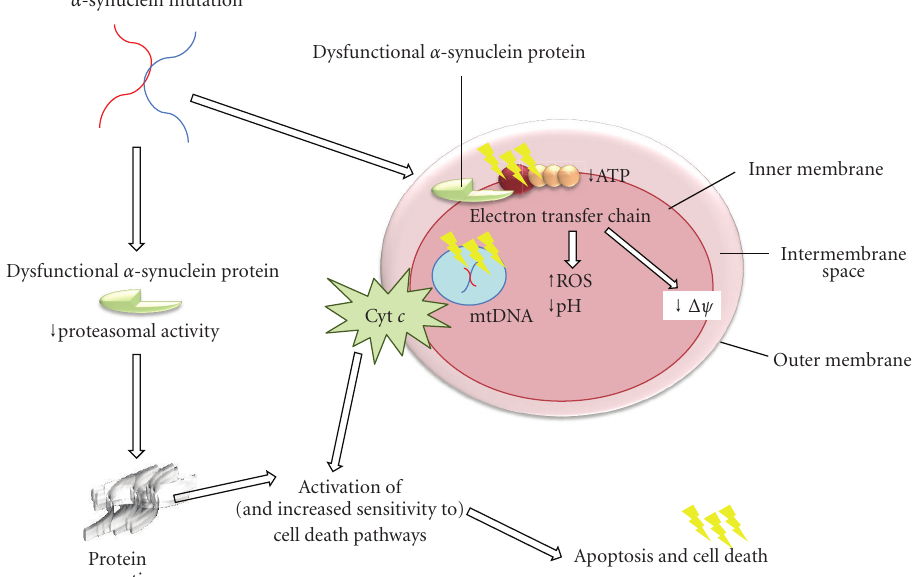
Figure 1: Genetic mutation of α -synuclein and subsequent protein and biochemical alterations . Modifications to the α -synuclein gene cause dysfunction of its protein product. Proteasomal activity becomes impaired, leading to an increased tendency for the protein to aggregate. Mutated α -synuclein protein also localises at the inner mitochondrial membrane, causing complex I dysfunction. ATP production is subsequently reduced, as is the transmembrane potential of the organelle. Increased levels of ROS result, and with mtDNA being particularly susceptible to ROS damage, further cell stress occurs. The acidic cytosolic environment created by ROS and metabolic impairment results in the activation of cell death mediators, such as cytochrome c . Apoptotic pathways are initiated and cell death subsequently occurs.